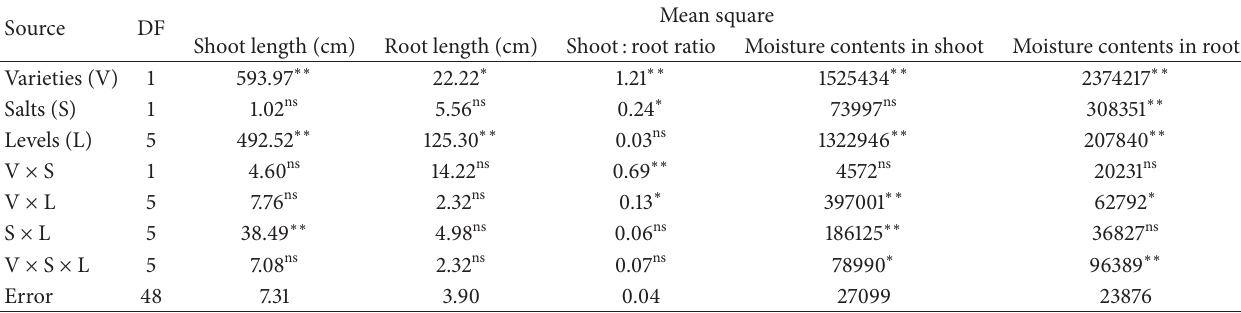
Table 1: Analysis of variance (ANOVA) table for shoot length, root length, shoot: root ratio, and moisture contents in shoot and root of sunflower cultivars under various arsenic